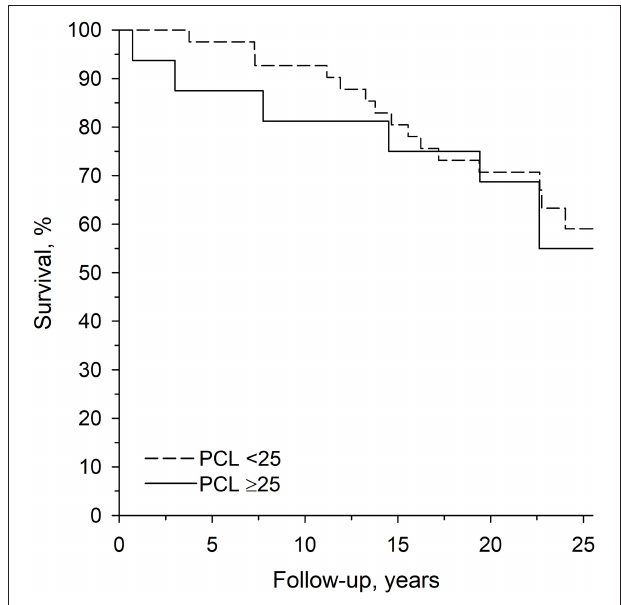
FIGURE 1 | Age-adjusted survival curves for low and high psychopathy groups.